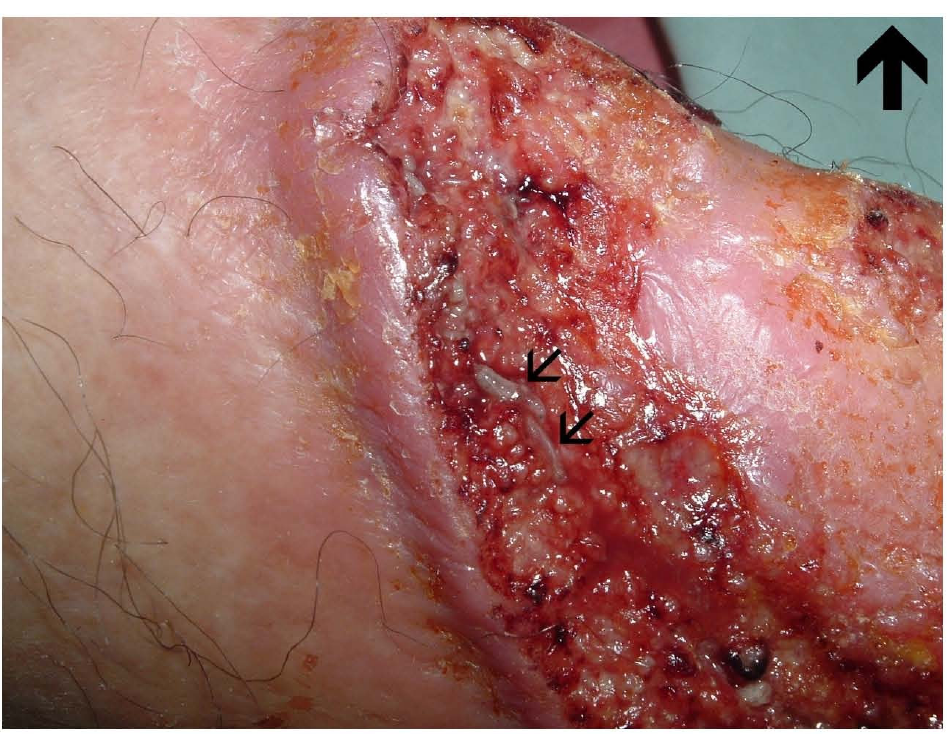
FIGURE 2. Close-up showing numerous larvae within the